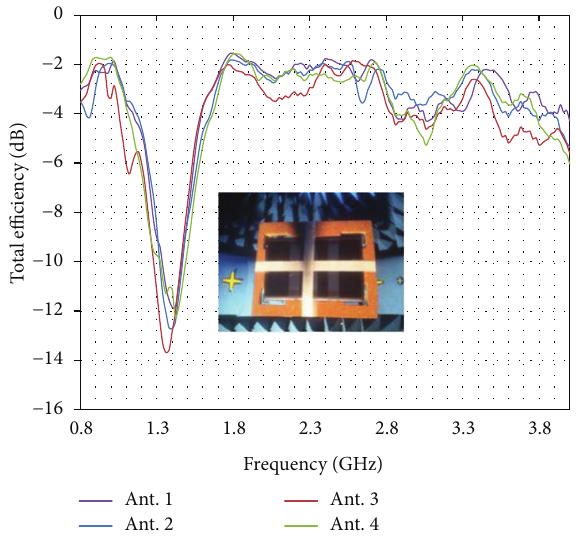
Figure 15: Measured total efficiency of the prototype in the realistic test